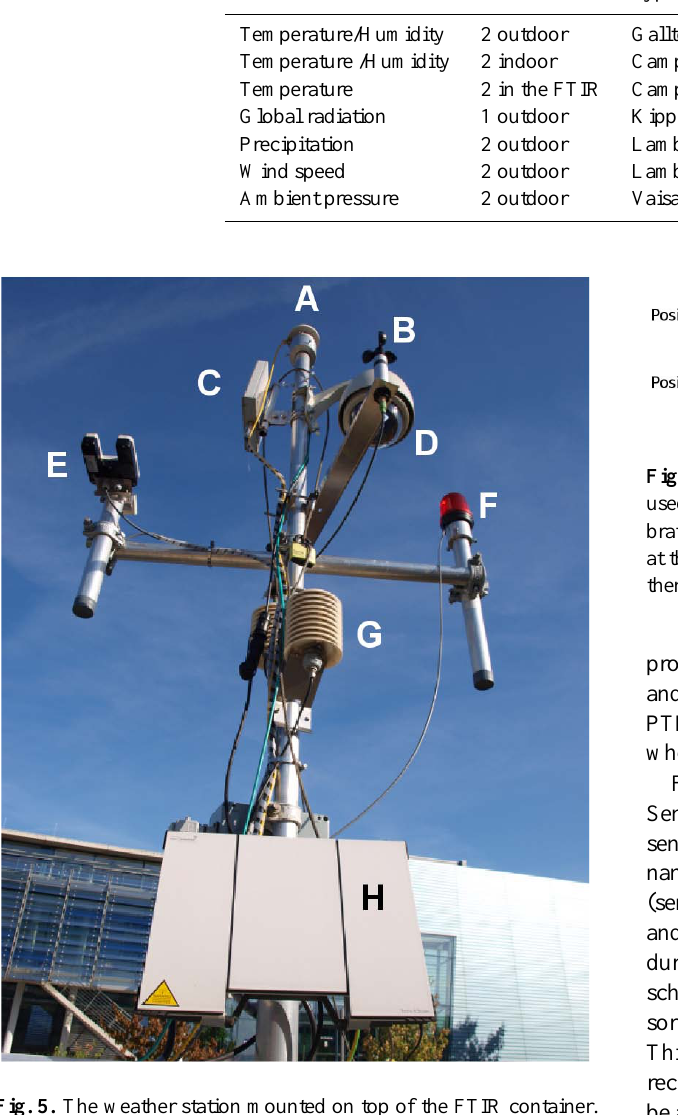
Fig. 5. The weather station mounted on top of the FTIR container. It measures temperature and humidity with two sensors (G). Wind speed is measured by two cup anemometers (B). It is also equipped with two different precipitaion detectors (E). On the very top, global radiation is measured by a pyranometer (A). The pole of the weather station also hosts two antennas for communication: a wireless LAN link (B) and a BGAN satellite receiver (H). Also an outdoor cam- era (D) and a signal LED (F) are mounted on the pole.